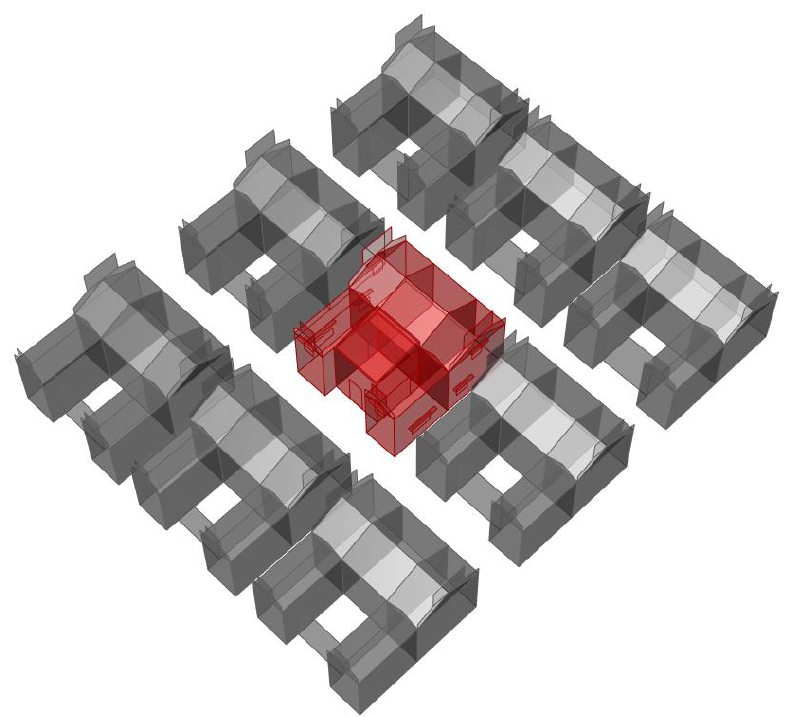
Figure. 4 A Xiashanhu parametric model (target building in red and surrounding buildings in